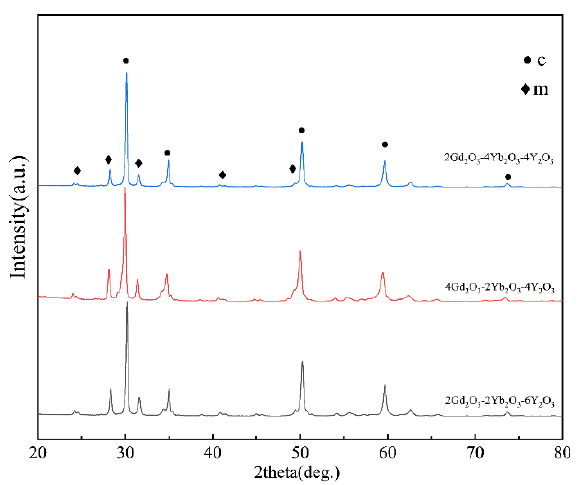
Figure 1. XRD patterns of as-fabricated 2Gd-2Yb-6Y, 4Gd-2Yb-4Y and 2Gd-4Yb-4Y powders.